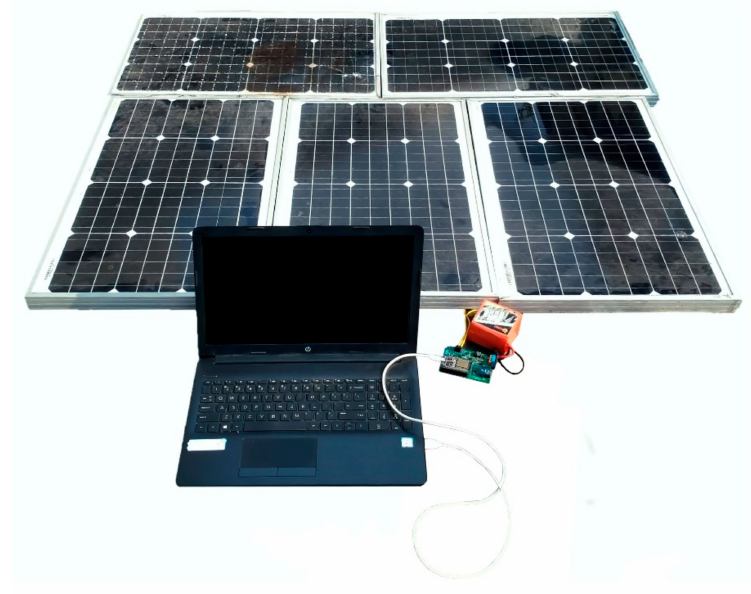
Figure 5. The real-time IoT-monitored PV power